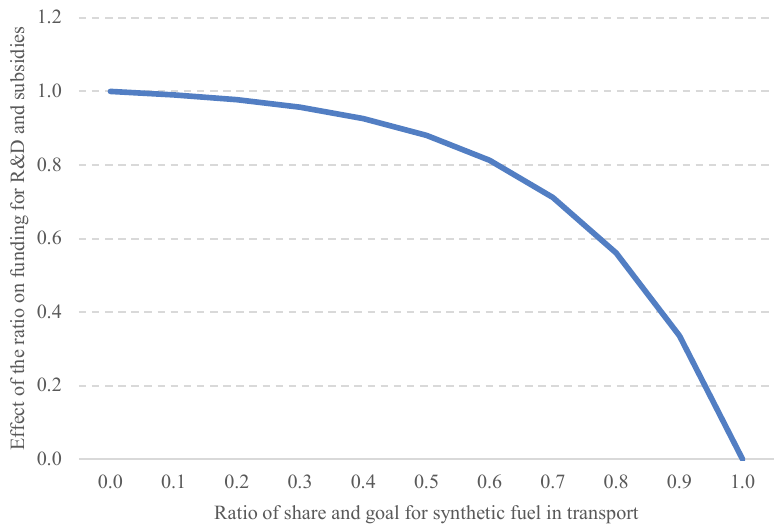
Fig. 3. Graph illustrating a feedback effect from the ratio of actual share and the goal for synthetic fuel in transport to funding allocated for R&D and ethanol production subsidies. When the goal is reached, the ratio becomes 1 and no funding is allocated. All funding, which is available, is allocated if the ratio is